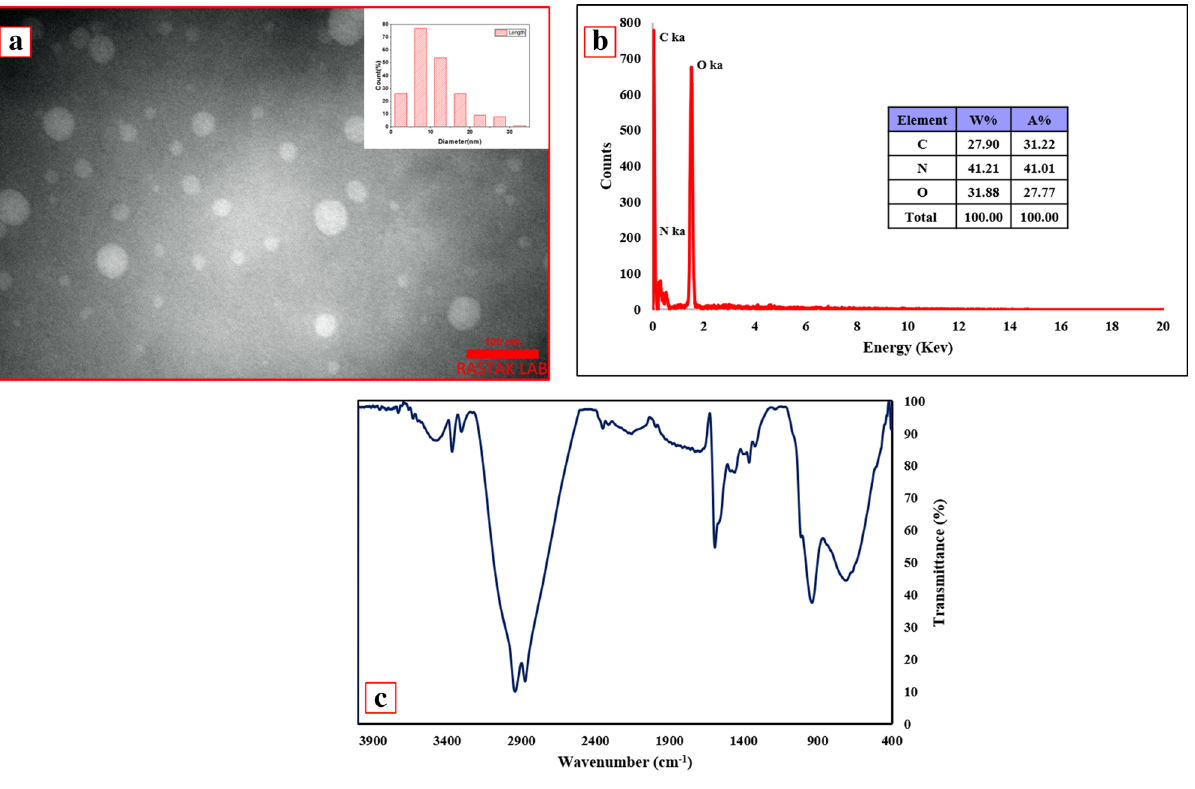
Figure 1. ( a ) TEM image and particle size distribution, ( b ) EDS analysis, and ( c ) FT-IR spectrum of amine-